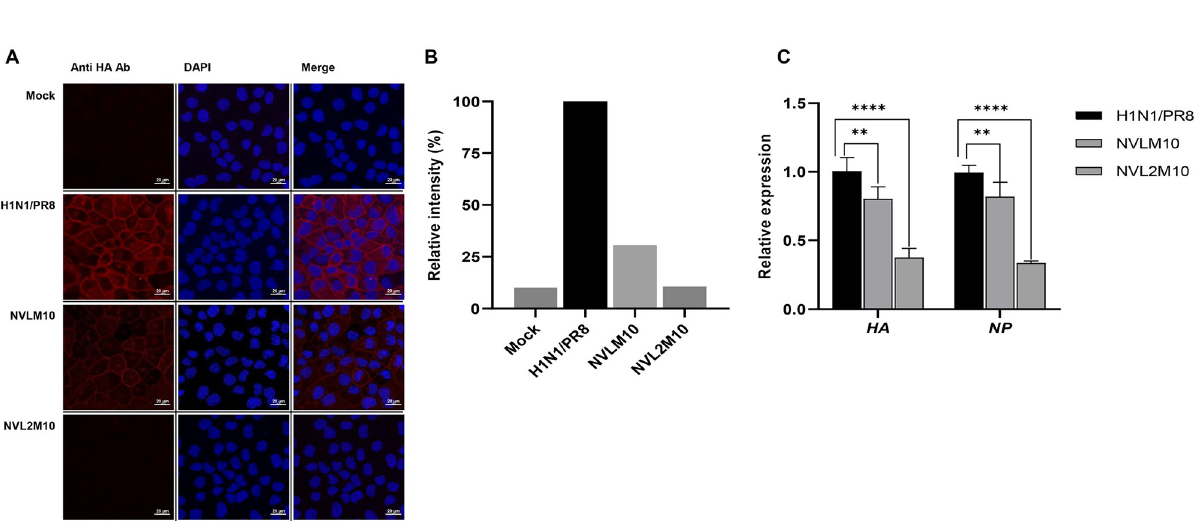
Fig 7. In vitro reductions of viral proteins and viral genome by NVLM10 and NVL2M10. (A) Visualization of HA protein expression in H1N1/PR8 (MOI 0.1) infected MDCK cells in the presence of 10 μ g each of NVLM10 and NVL2M10 compared to H1N1/PR8-infected and mock cells at 24 hpi (magnification 40X). The HA proteins of influenza H1N1/PR8 were detected using the primary polyclonal rabbit anti-HA antibodies. (B) The viral protein signal was converted to relative intensity percentages using the histogram function in Zen 3.1 (blue edition) program, by normalizing to the DAPI signal and using untreated samples as a calibrator. (C) At 24 hpi, H1N1/PR8 infected MDCK cells were collected and processed for RTqPCR. The relative expression of viral gene HA and NP was quantified to compare H1N1/PR8 with NVLM10 and NVL2M10 (treated) to that of H1N1/PR8 untreated group. Unpaired t test were used to determine p value ( �� p < 0.005, ���� p < 0.0001).